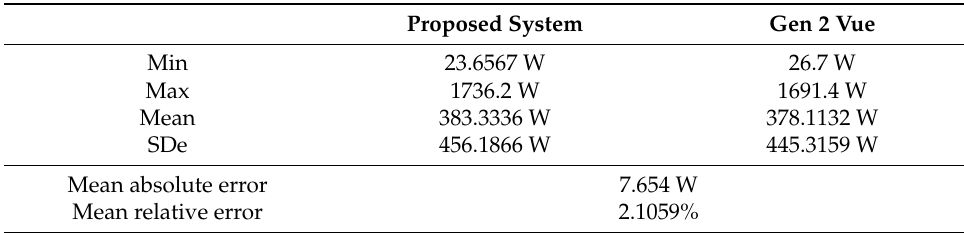
Table 8. Active power data in line 1 obtained by both monitors.